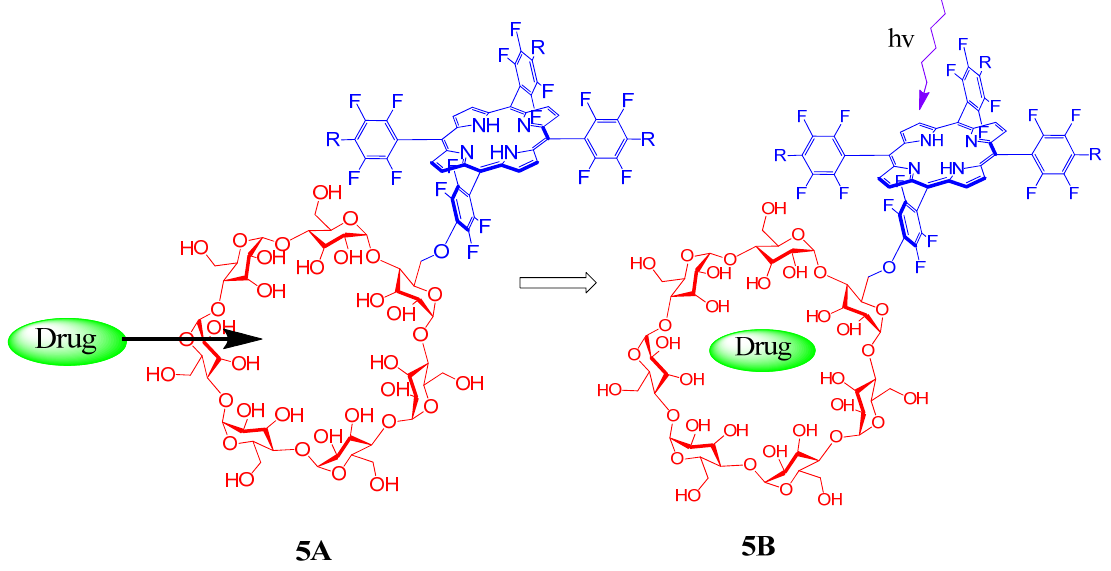
Figure 5. Schematic representation of combined chemotherapy and photodynamic therapy